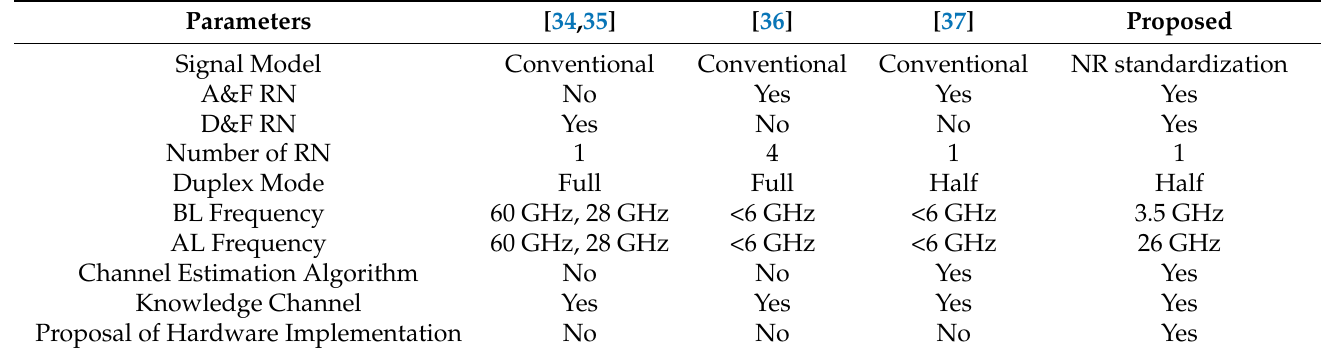
Table 4. A comparison survey with previous